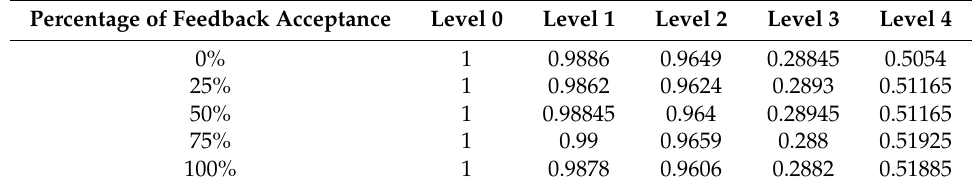
Table 10. User trust levels concerning efficiency when there is a high error rate at level 3 and the user is cautious.